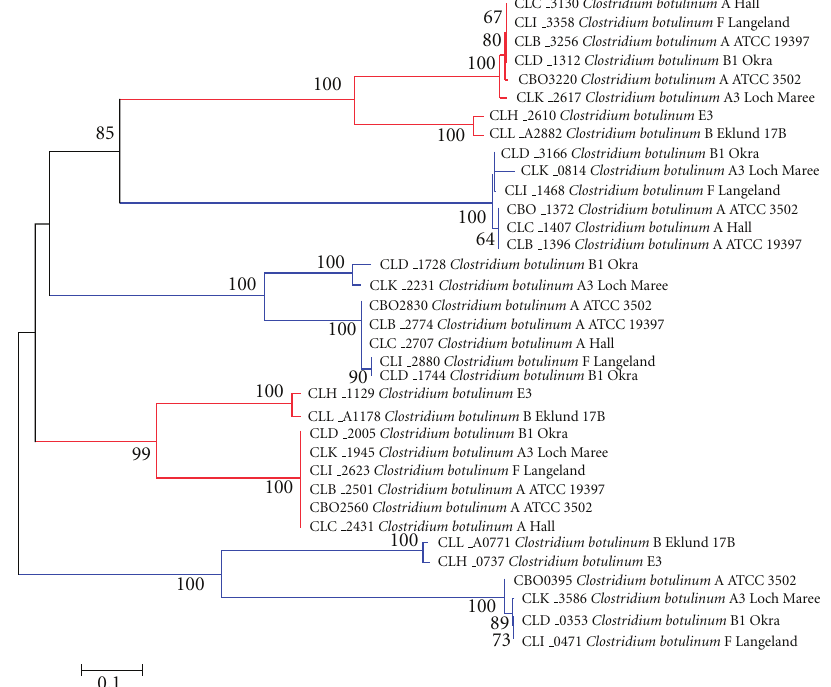
Figure 1: The phylogenetic tree of Fur transcription regulators in Clostridium